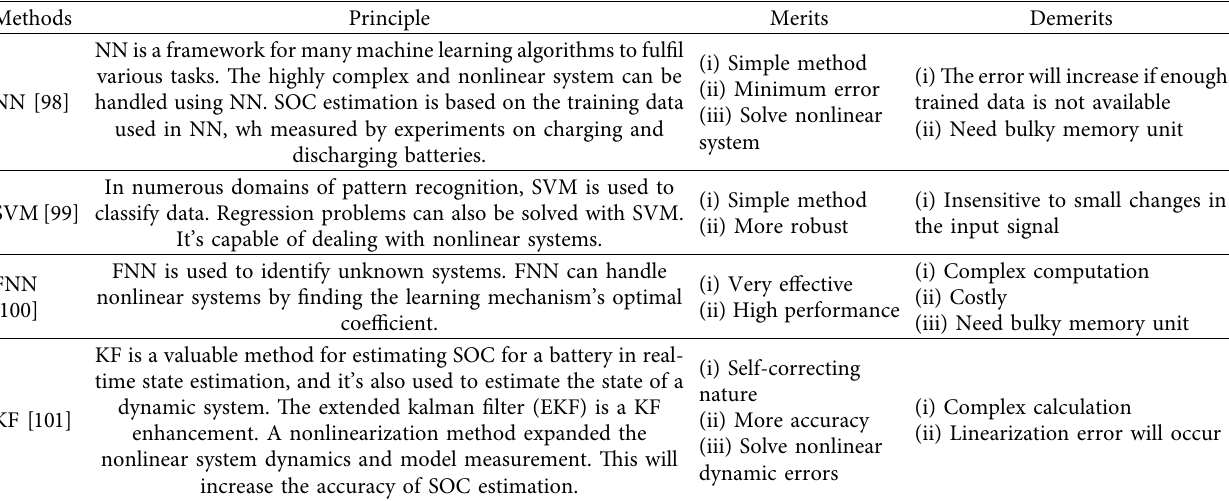
Table 5: Comparison of an adaptive method of SOC estimation.